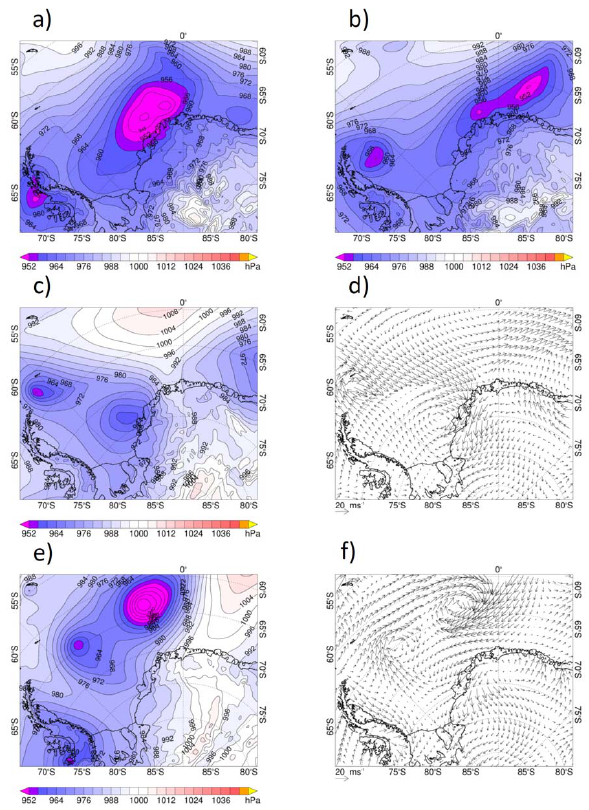
586 Figure 5. ERA ‐ Operational meteorological maps around the Weddell Sea region at various times 587 Fig. 5. ERA-Operational meteorological maps around the Weddell during the major August ozone depletion event. a) mean sea level pressure (mslp) at noon on 16 th 588 Sea region at various times during the major August ozone deple- tion event. (a) Mean sea level pressure (mslp) at noon on 1 August; (b) mslp at midnight at start of 17 August; (c) mslp at midnight at start of 18 August; (d) 10-m wind vectors at midnight at start of 18 August; (e) mslp at midnight at start of 19 August; (f) 10-m wind vectors at midnight at start of 19 August.